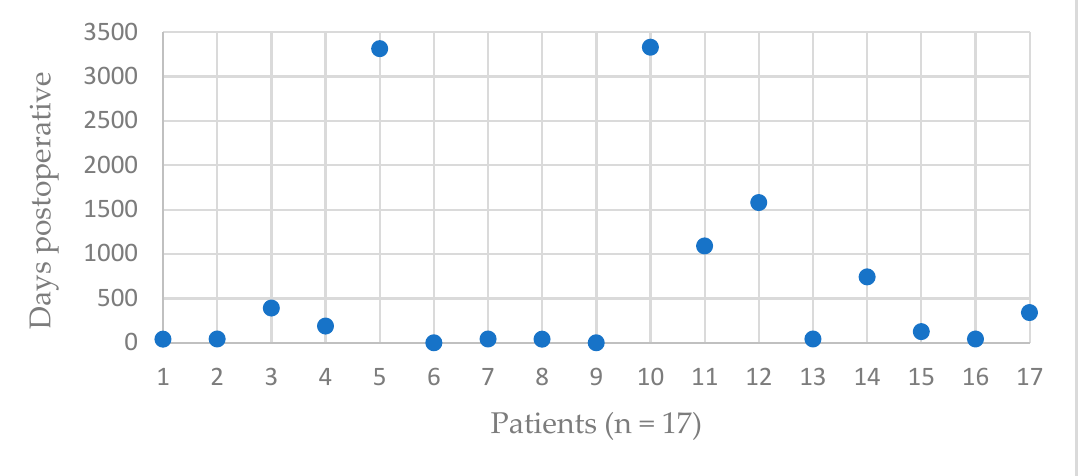
Figure 1. Occurrence of GTP depending on the time.